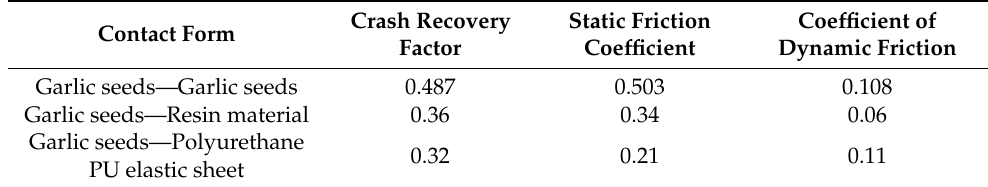
Table 3. Simulation